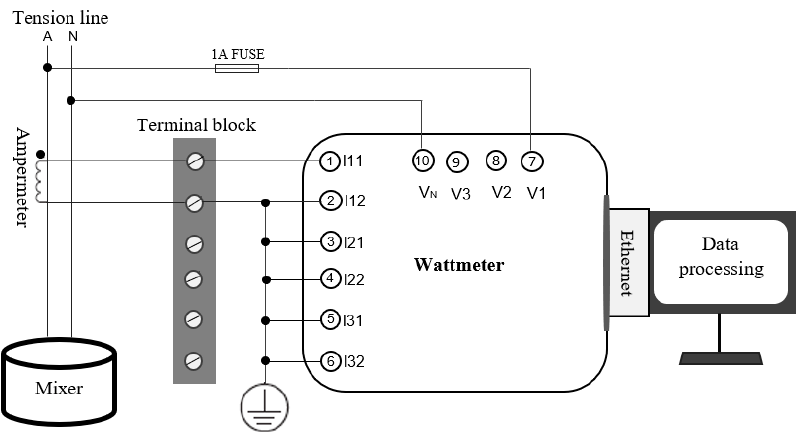
Figure 2. Simplified diagram of the mixing energy station.